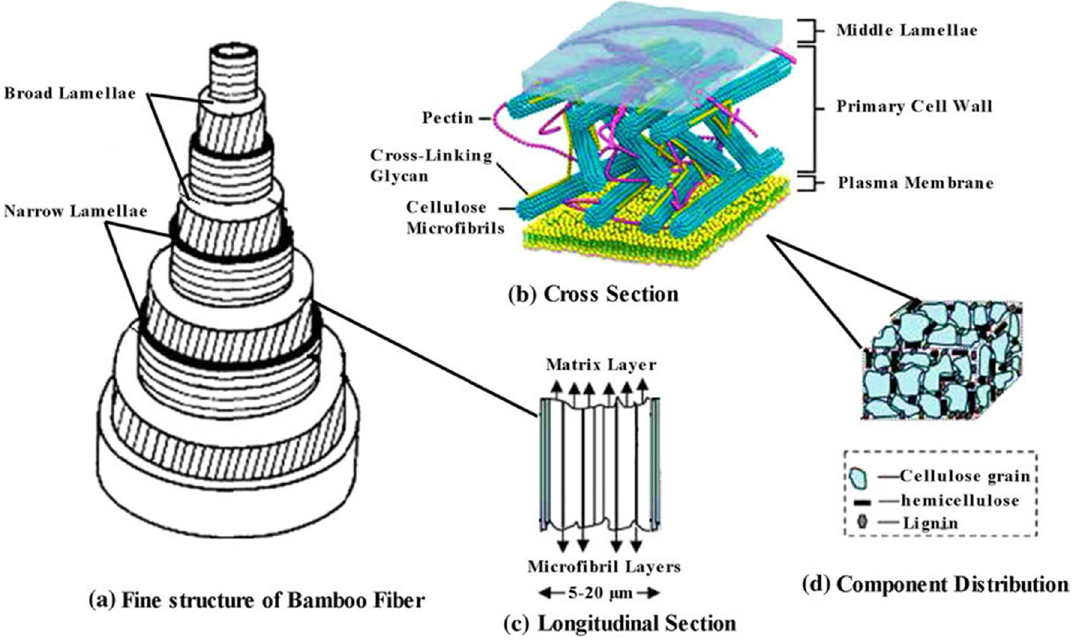
Figure 3: ( a ) Model of the structure of a bamboo cell wall [ 74 ] , ( b ) the middle lamella is the outer - most layer, followed by the primary wall [ 74 ] , ( c ) the short tiny fi bers [ 74 ] , ( d ) nanoscopic scale cellulose grains with orientation and other components [ 74 ] . ( Reprinted from Parameswaran and Liese [ 72,73 ] by Liu et al. [ 74 ]) .